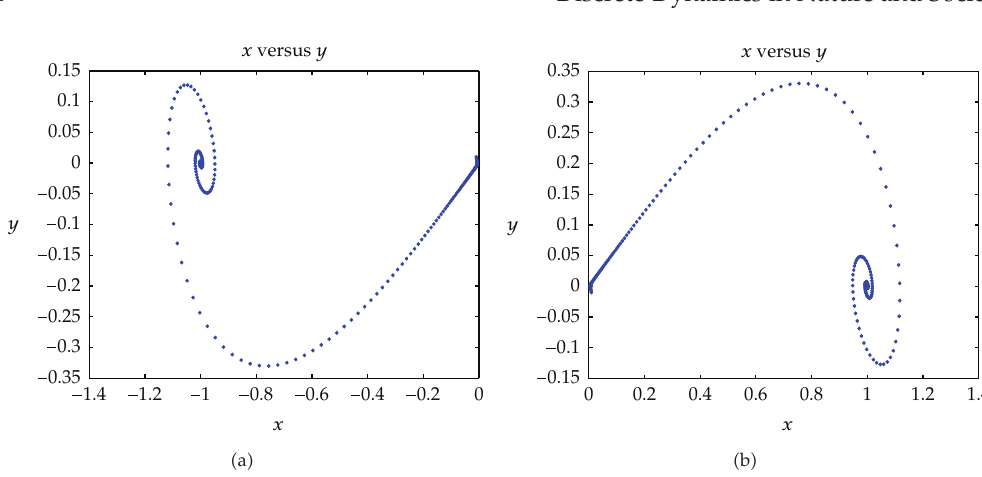
Figure 1: W -asymptotical stability of system (cid:2) 2.6 (cid:5) with di ff erent initial values. (cid:2) a (cid:5) and (cid:2) b (cid:5) show phase